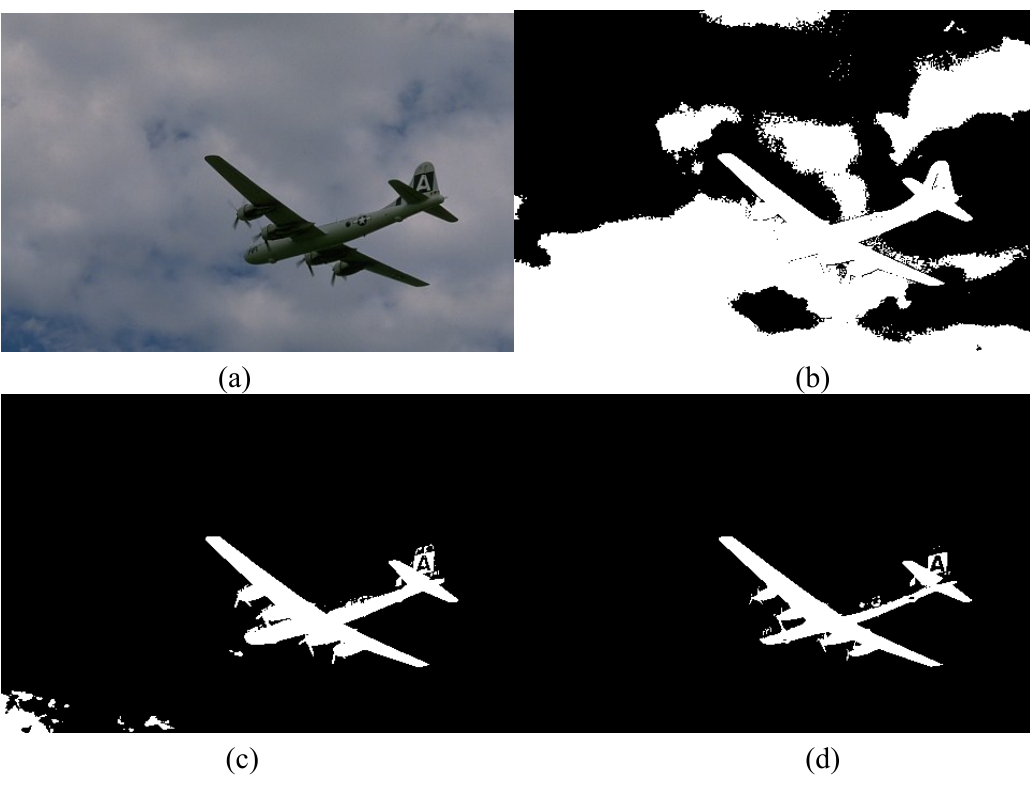
Figure 8. The segmentation result of “plane” image: (a) “plane” original image; (b) the result of KFCM_F; (c) the result of FCM_S; (d) the result of the proposed